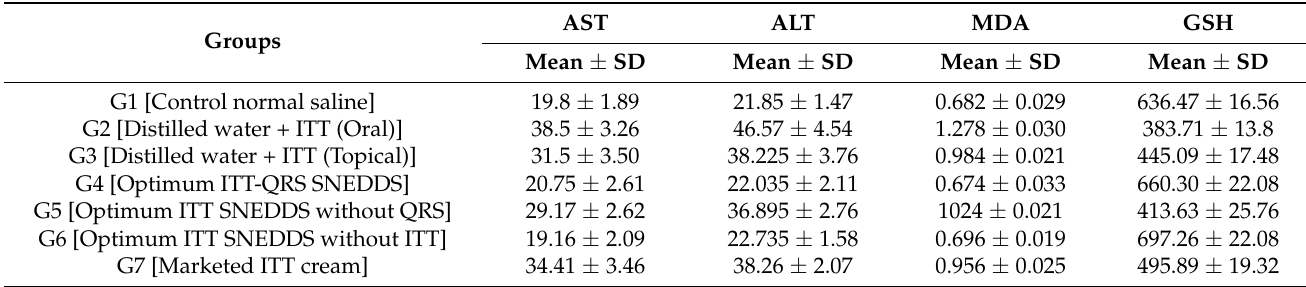
Table 9. The effect of various formulation ingredients on hepatoprotective activity in comparison with the marketed formulation.